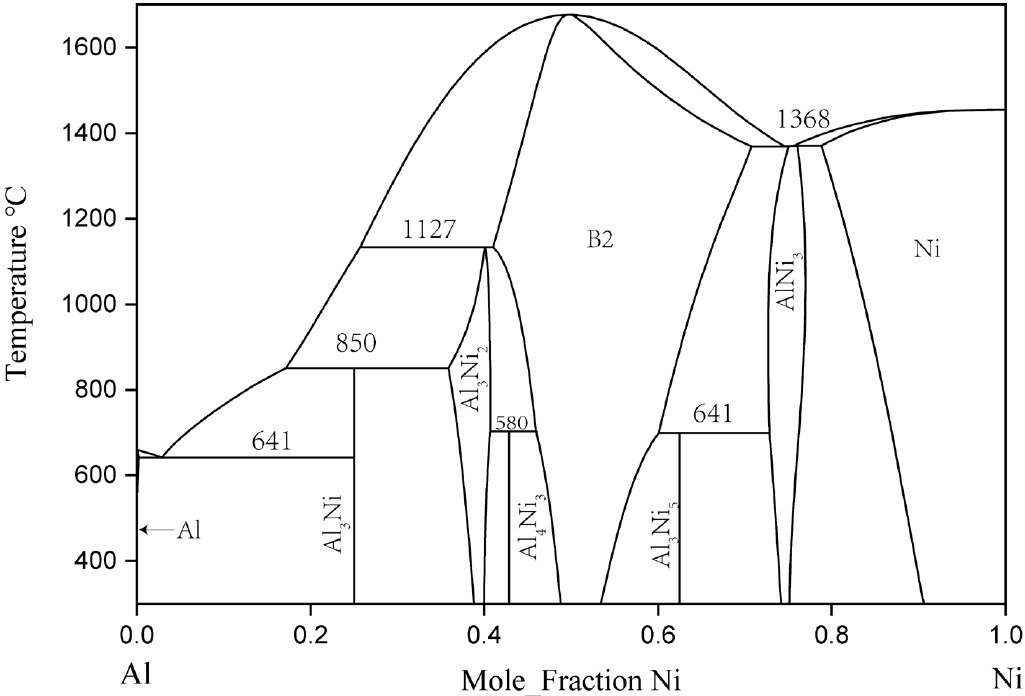
Figure 1. Al–Ni phase diagram [14,22].